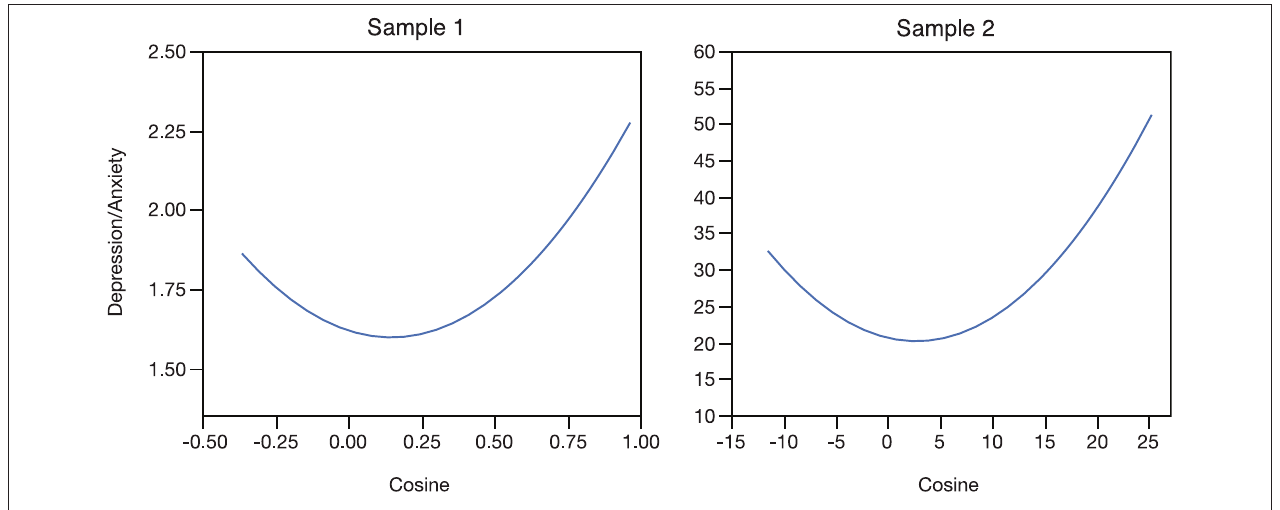
FIGURE 3 | Polynomial regression lines of the individuals’ average level of depression/anxiety regressed on their individual cosine coefficient, presented separately for the two samples. “Depression/Anxiety” is the individual-level mean across two menstrual cycles on the Depression/Anxiety scale, which is the mean of the depression and anxiety scales, which are the means of individual questionnaire